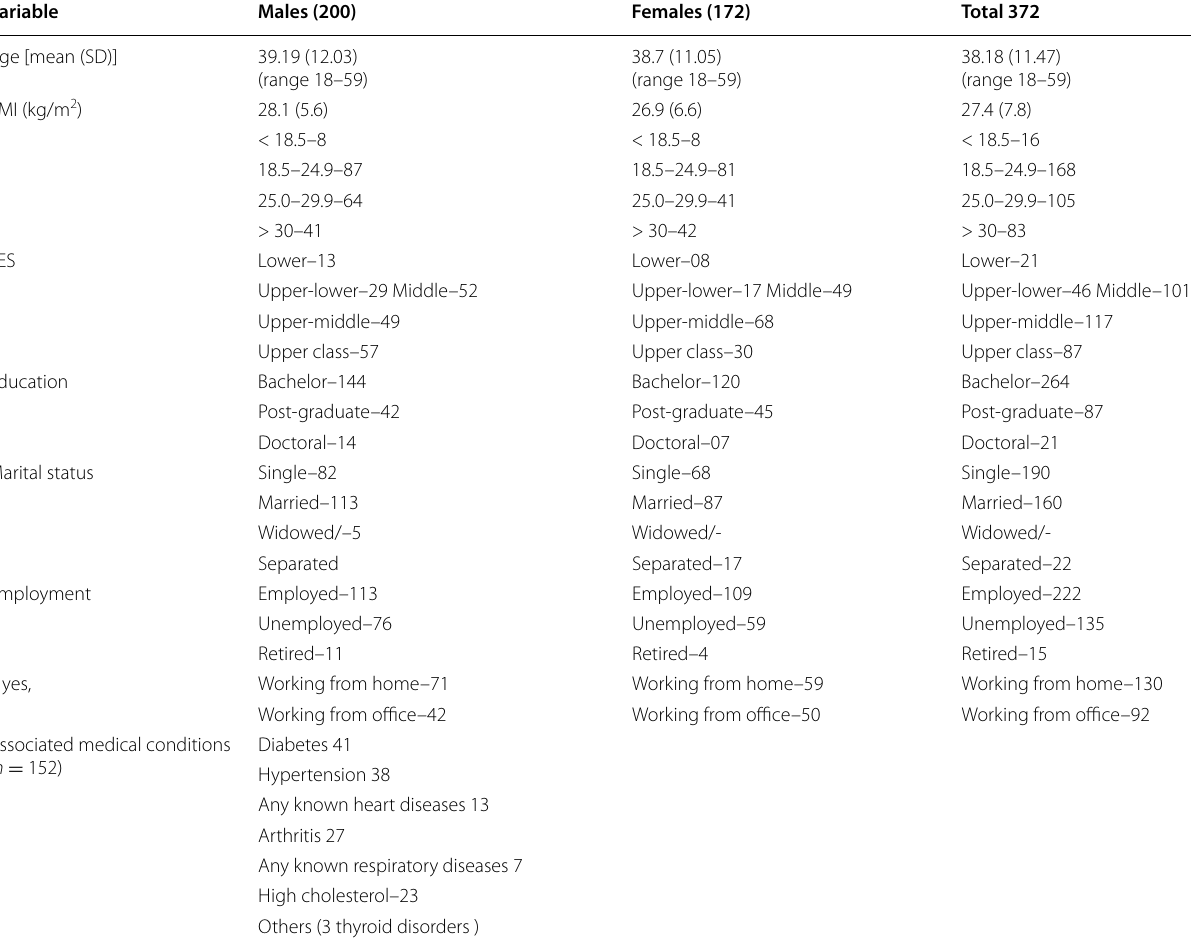
Table 1 General characteristics of the study